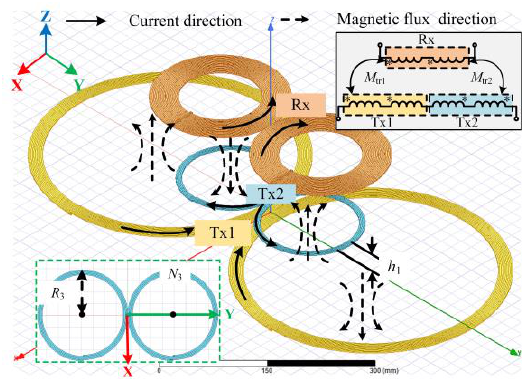
Figure 5. The structure of the proposed compound DD coils.